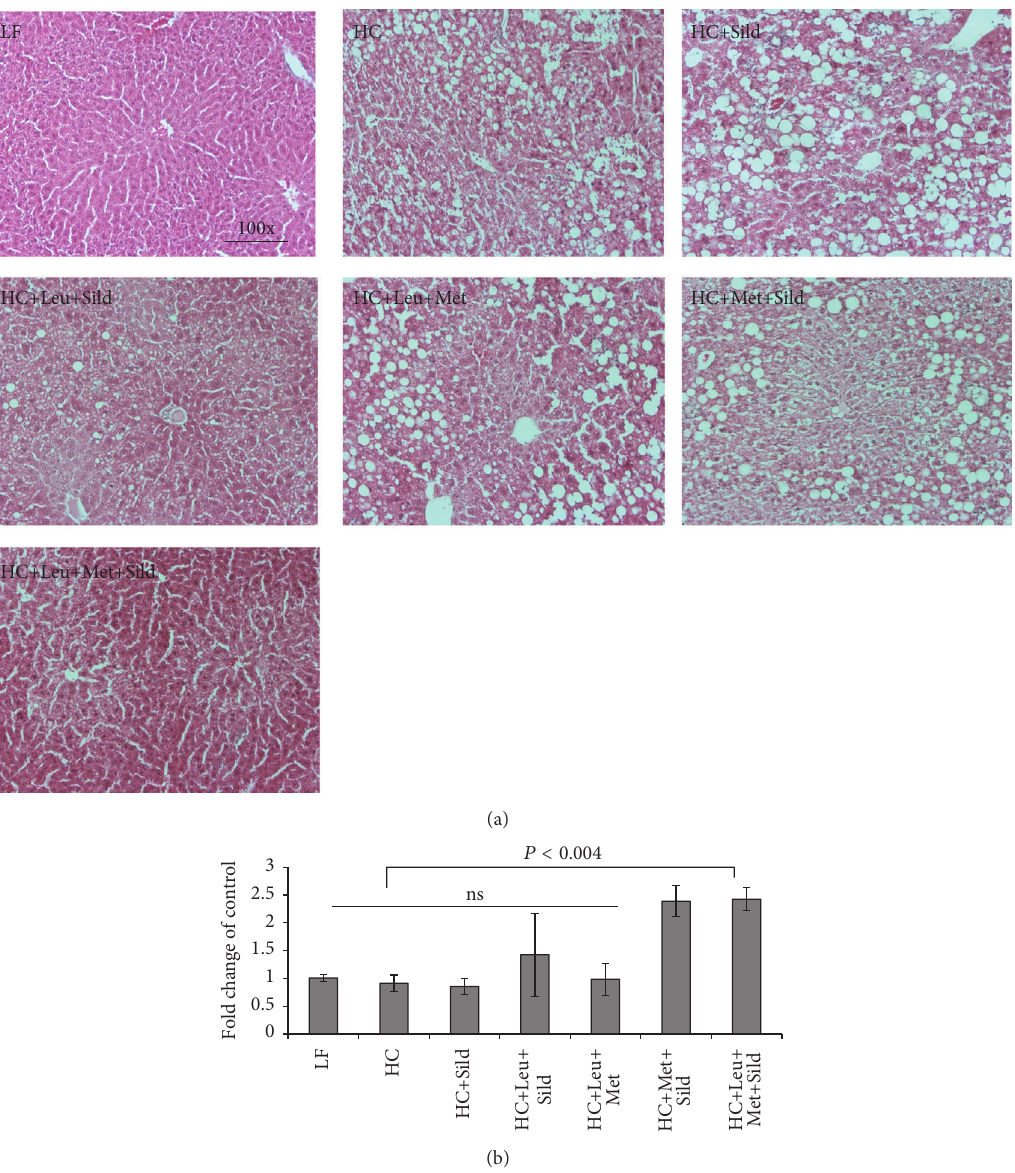
Figure 7: Sild-Met-Leu effects on liver histology in mice. Mice were fed a low-fat (LF) diet or high-fat atherogenic (HC) diet for 6 weeks and then randomized to the indicated treatment groups for an additional 6 weeks. (a) Liver sections were stained with hematoxylin and eosin (H&E) at the end of the study. Representative images for each group are shown. (b) PPAR alpha gene expression in liver extracts was measured and expressed as mean ± SEM of fold change of control ( 𝑛 = 6 ). Sild: sildenafil, Met: metformin, Leu: